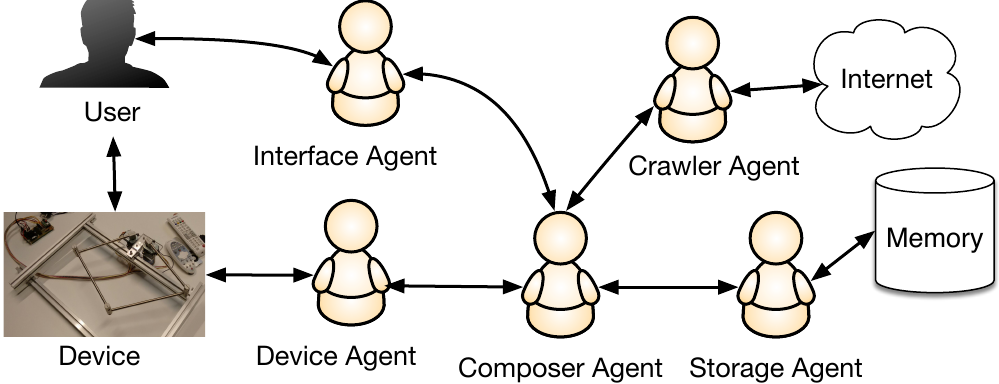
Figure 2. Illustration of the MAS developed for the